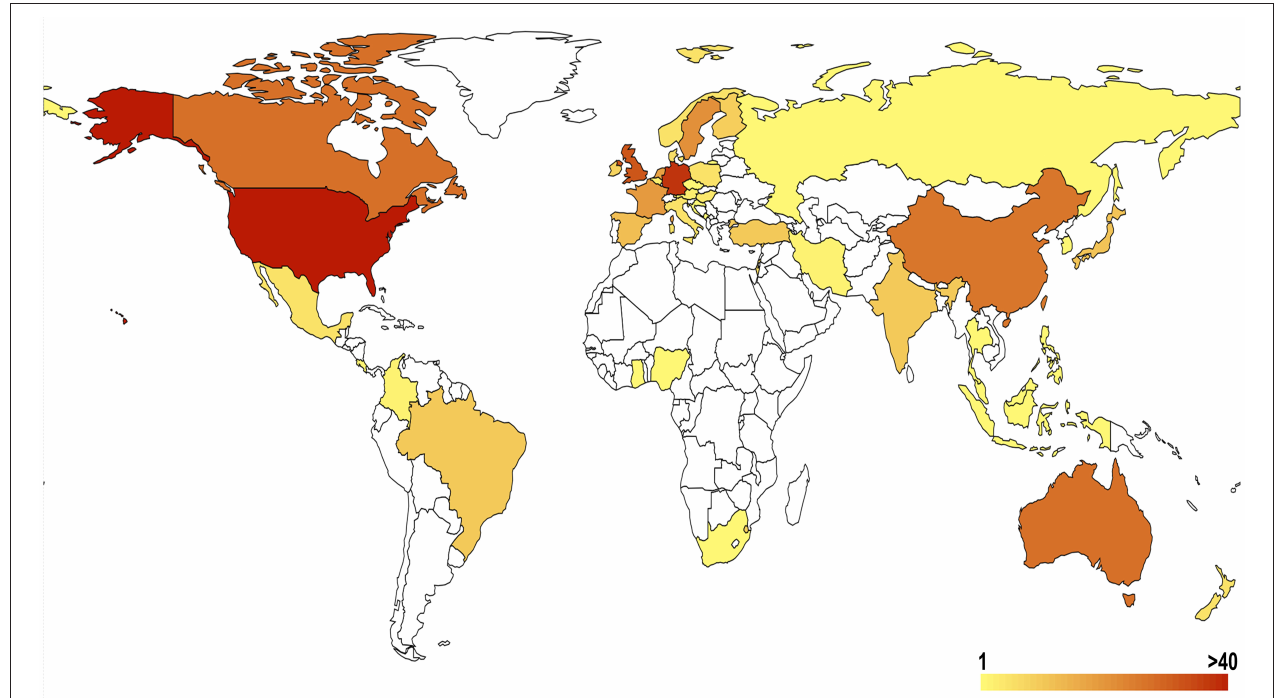
FIGURE 3 | Geographical distribution of substance-related disorders publications. Redness degree is positively correlated with publication numbers.